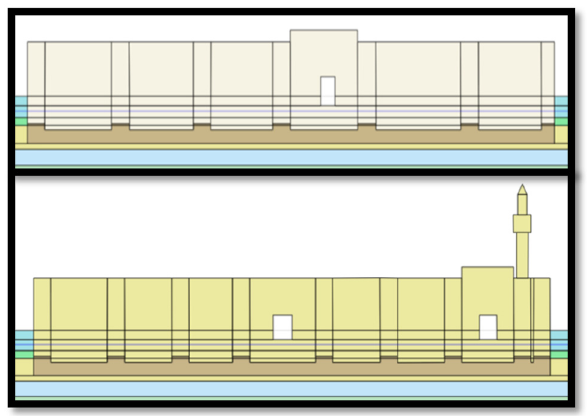
Figure 4: The soil layers, foundations, and walls of Al - Kufa Mosque represented in fi nite element